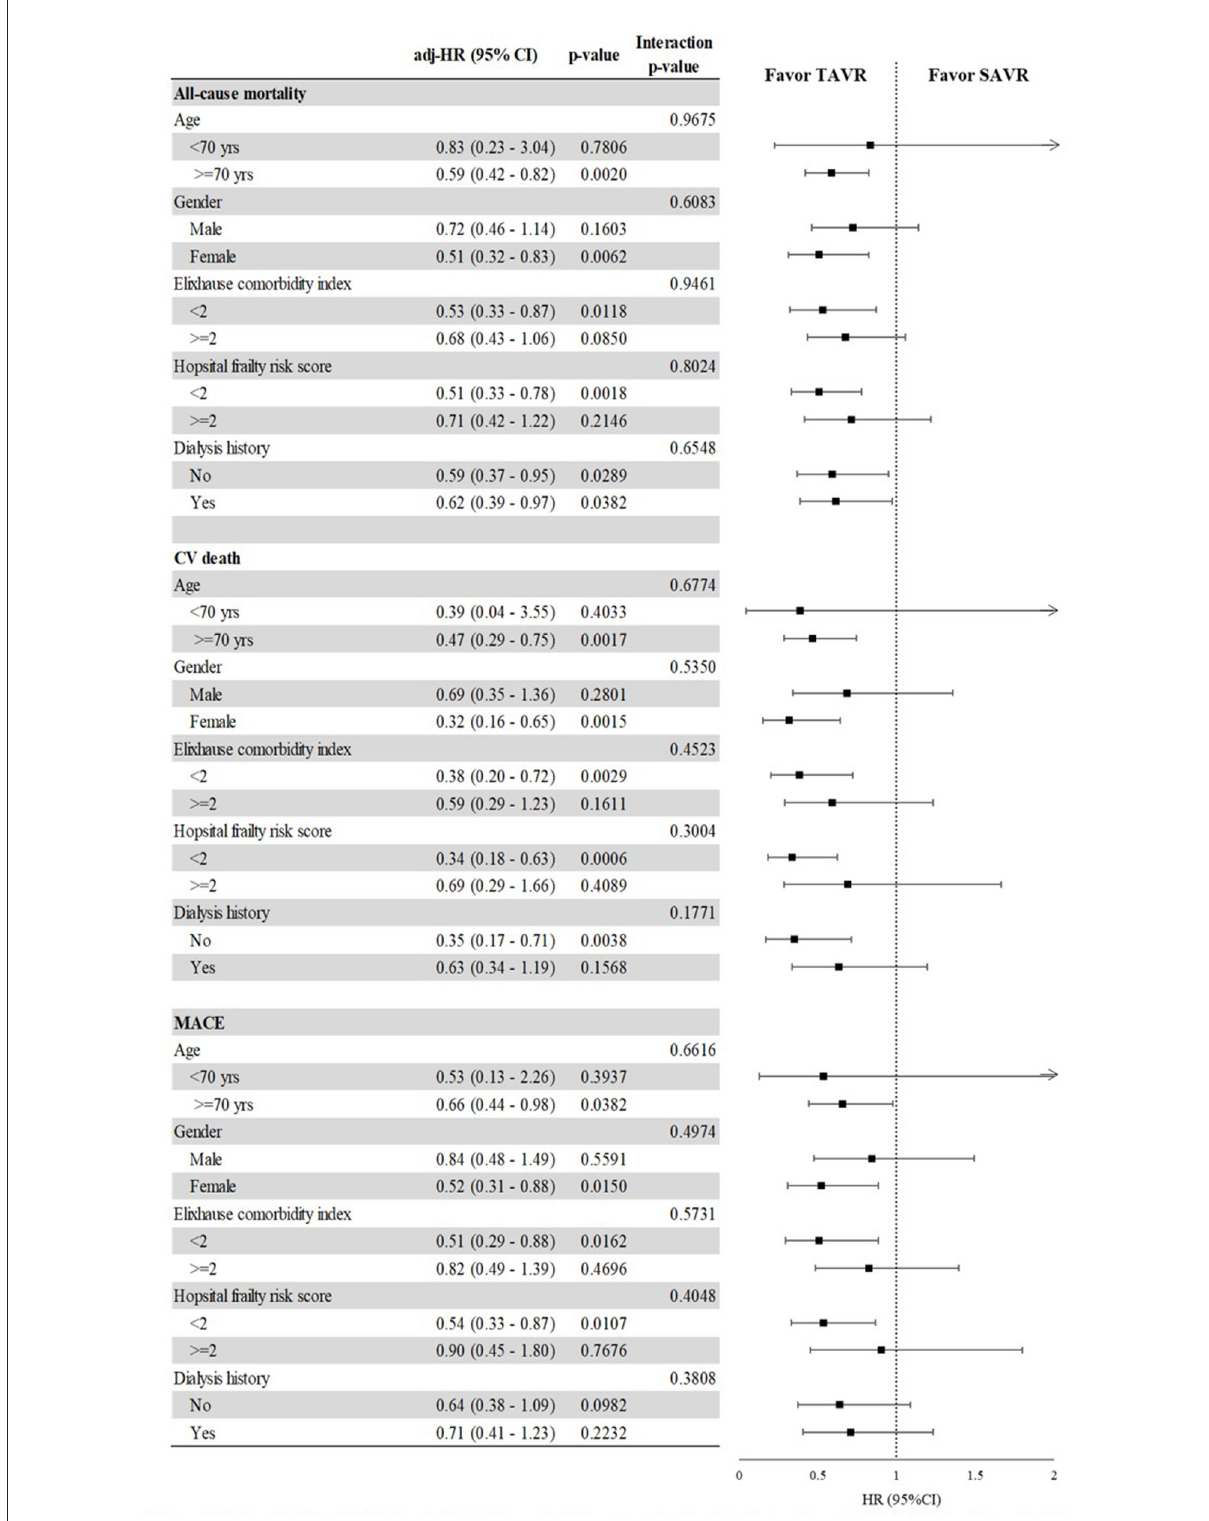
FIGURE3 The impact of the interaction between selected categories and TAVR vs. SAVR on the risk of all-cause mortality, CV death, and MACE, after propensity score overlap weighting. Comparison of TAVR and SAVR in terms of MACE, CV death, and ACM among selected baseline characteristics after propensity score overlap weighting. Subgroup analysis comparing TAVR and SAVR as a function of age group, gender, comorbidity score, hospital frailty risk score, and history of dialysis. Outcomes included in the subgroup analysis were all-cause mortality, cardiovascular death, and major adverse cardiovascular